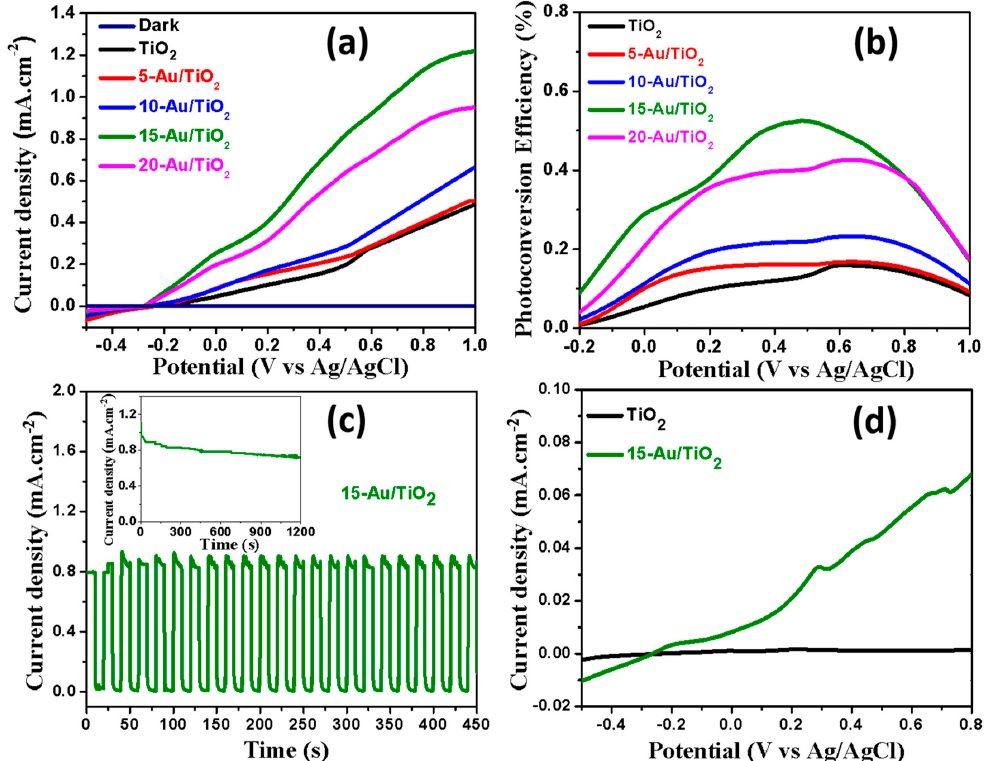
Figure 7. ( a ) Current densities and ( b ) corresponding photoconversion efficiencies of Au/TiO 2 NFs with different UV irradiation times. ( c ) I–t curve and photocurrent (inset) of 15 ‐ Au/TiO 2 NFs sample at V bias = 0.5 V vs. (Ag/AgCl) with on/off cycles and continuous light illumination, and ( d ) I–V curves of pure TiO 2 NFs and 15 ‐ Au/TiO 2 NFs samples under green ‐ light illumination ( λ = 540 nm).